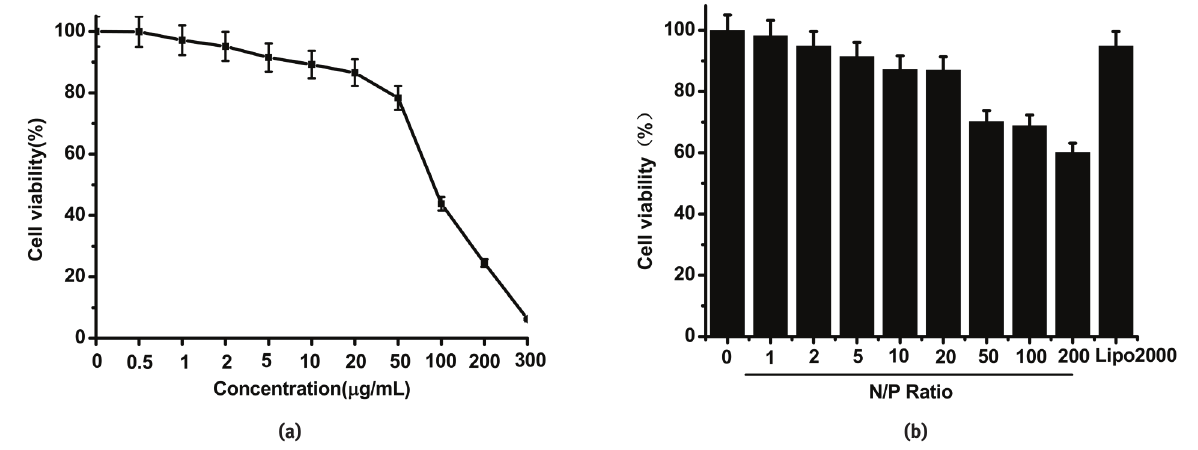
Figure 4: (a) Left: Cytotoxicity of PEG-PEI in PC-3 cells determined by a CKK-8 assay.xPC-3 cells were treated with PEG-PEI at various concentrations from 0 to 300 μg/mL. (b) Right: Cytotoxicity of PEG-PEI/miR-scr polyplexes in PC-3xcells at various N/P ratios from 0 to 200. The dose of miR-scr was 100nMxper well and incubation time was 24